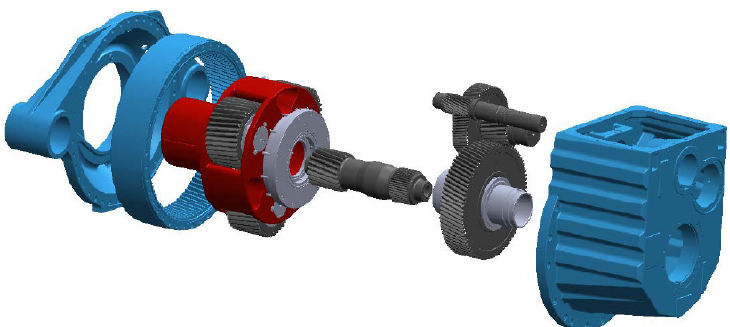
Figure 3. View of the gearbox internal components [16].